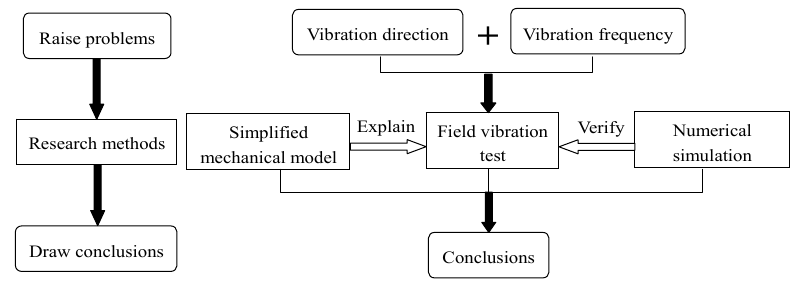
Figure 1. Schematic diagram of technology route.